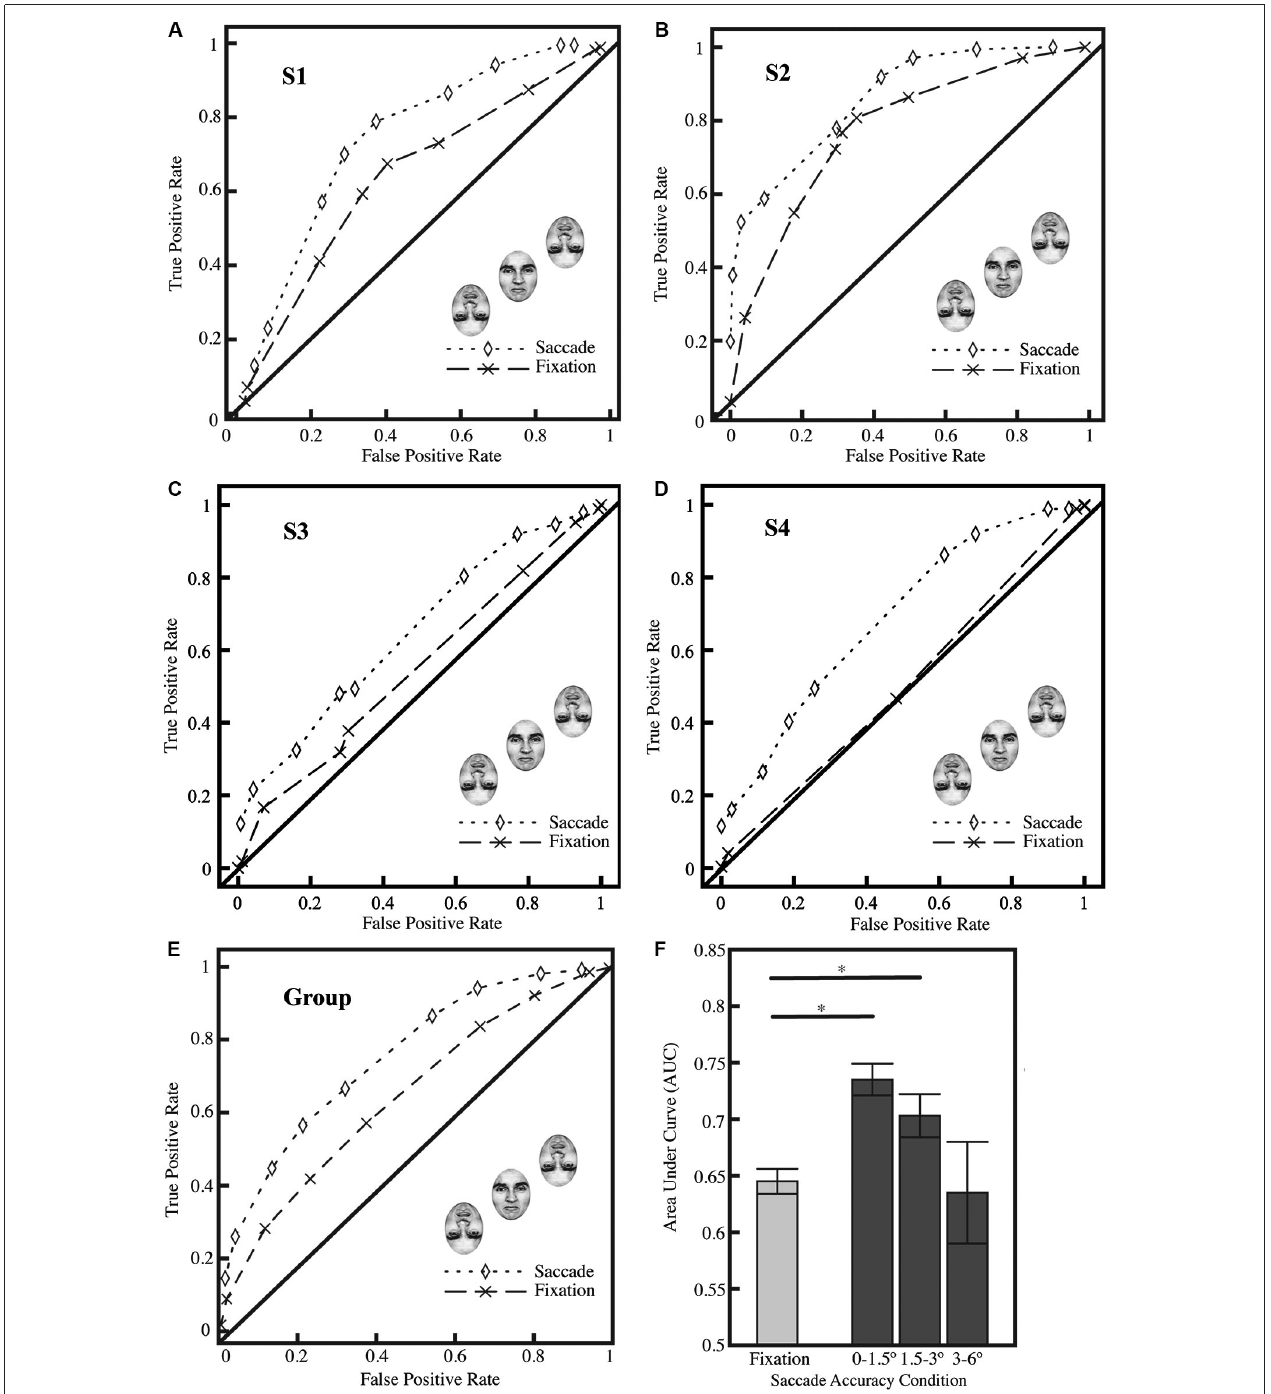
center of the face showed the greatest improvement in performance; the effect was reduced with less accurate saccades (landing ± 1.5–3.0 ◦ from the center of the face). The AUC in the fixation represents a baseline level of performance on the task. A Z -test was performed and the Z -score converted to a p -value using the standard normal distribution (Hanley and McNeil, 1982), and was then used to compare AUCs between the fixation condition and difference saccade accuracy windows; asterisks indicate significance at p < 0.05. Standard errors were estimated using the procedure of Hanley and McNeil